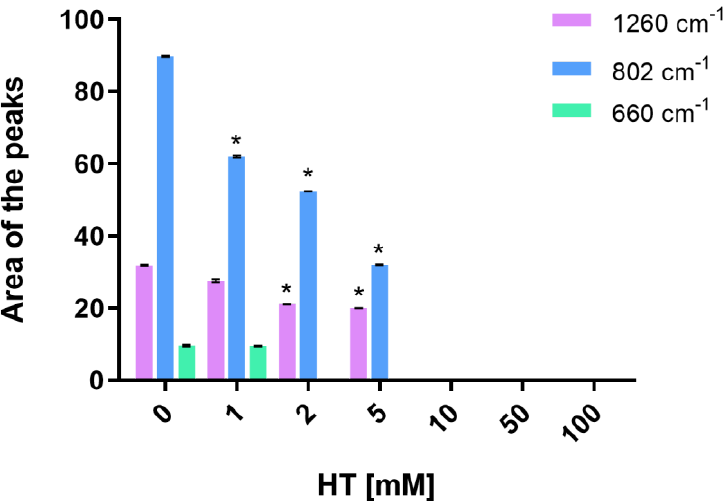
Figure 4. Change in the areas of the peaks of interest (1260 cm –1 , 802 cm –1 , and 660 cm –1 ) in irradiated phosphate buffer-based PEO hydrogels when increasing HT concentration; * p < 1 × 10 − 4 vs. HT 0 mM samples. Table 1. High-performance liquid chromatography ( HPLC) quantification of residual HT in phosphate and citrated buffer PEO 4% hydrogels after gamma-ray irradiation.